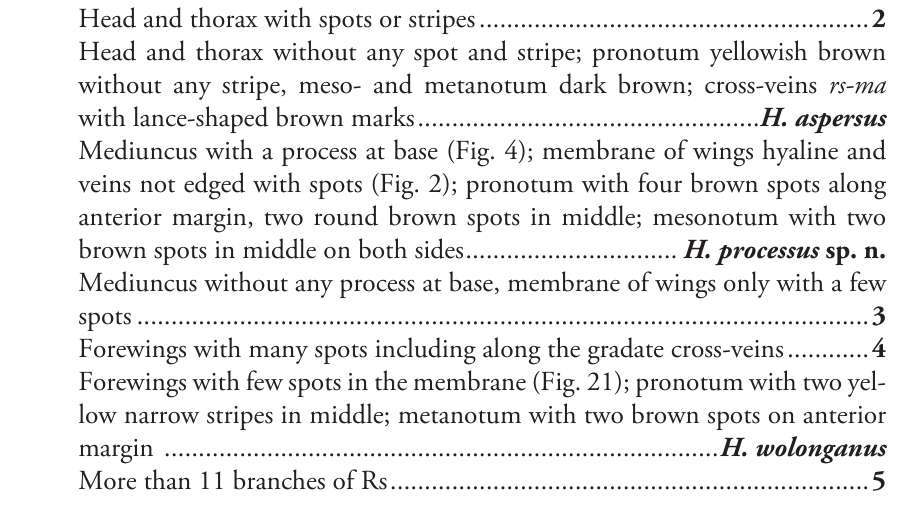
– Head and thorax without any spot and stripe; pronotum yellowish brown without any stripe, meso- and metanotum dark brown; cross-veins rs-ma 2 Mediuncus with a process at base (Fig. 4); membrane of wings hyaline and veins not edged with spots (Fig. 2); pronotum with four brown spots along anterior margin, two round brown spots in middle; mesonotum with two – Mediuncus without any process at base, membrane of wings only with a few